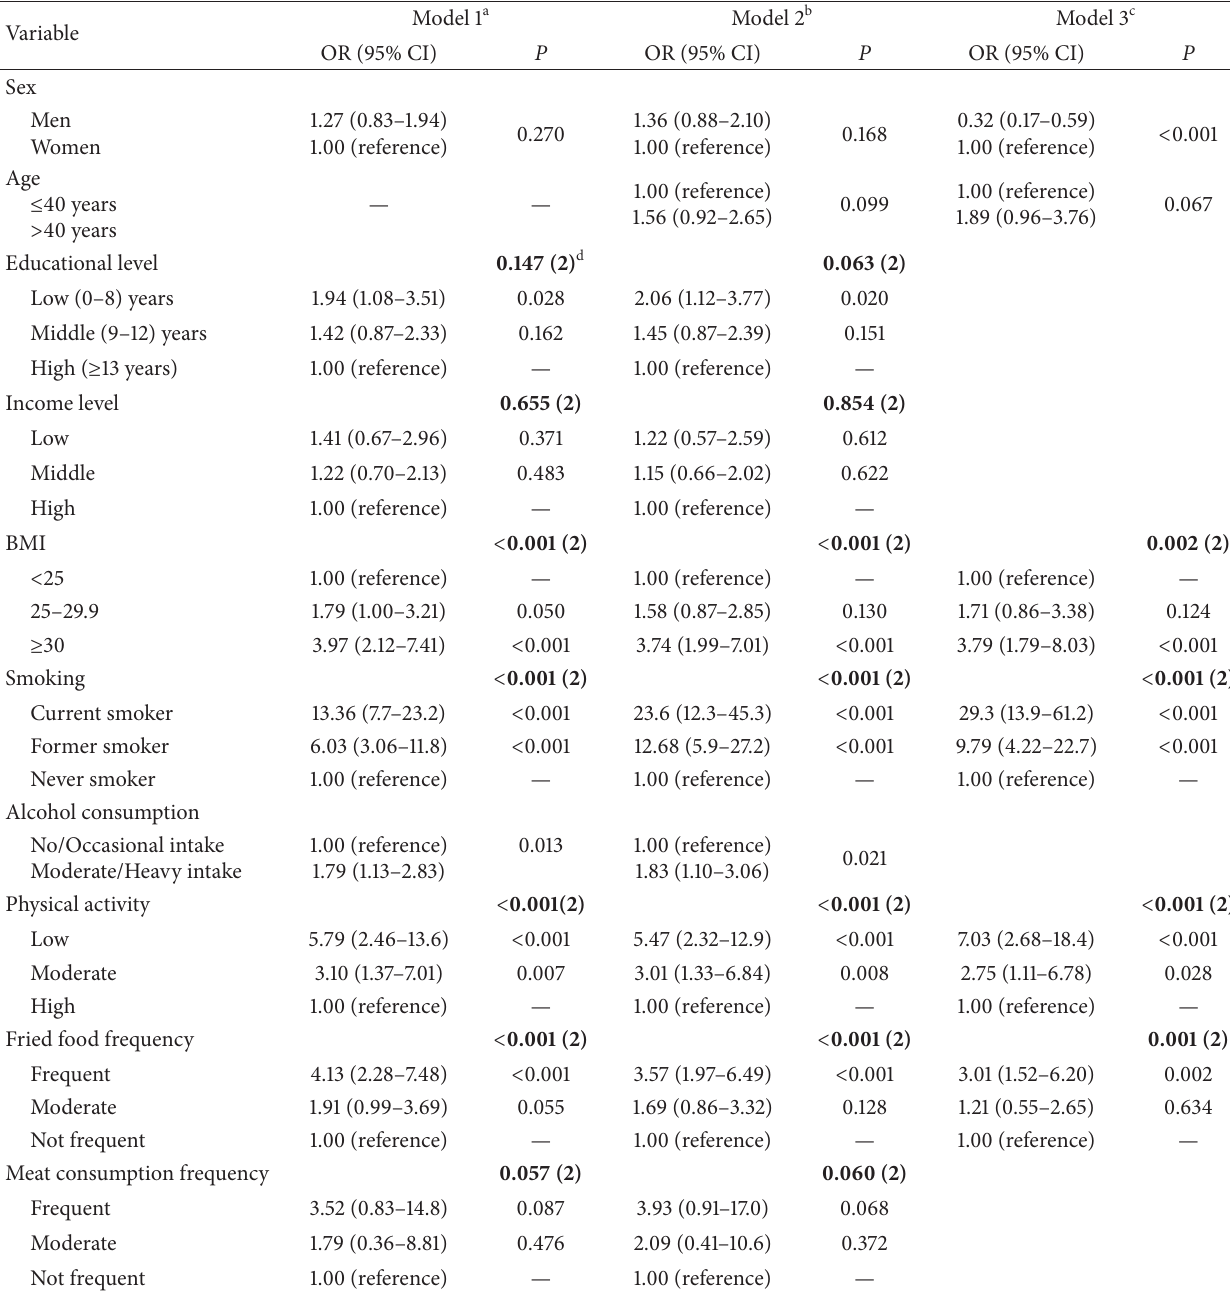
Table 3: Association of demographic, socioeconomic, and lifestyle factors with GERD; age-adjusted and multivariable-adjusted odds ratios (ORs) from binary logistic regression.